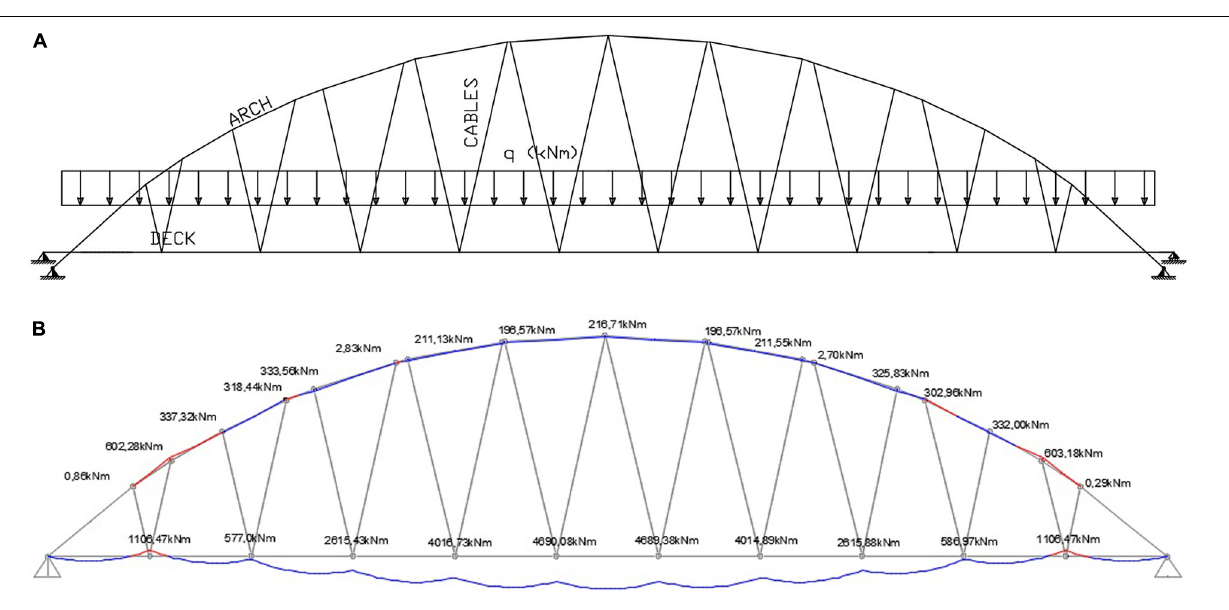
FIGURE 5 | Illustration of load case 1. (A) Load distribution. (B) Bending moment distribution over the deck and the arch in absence of cable